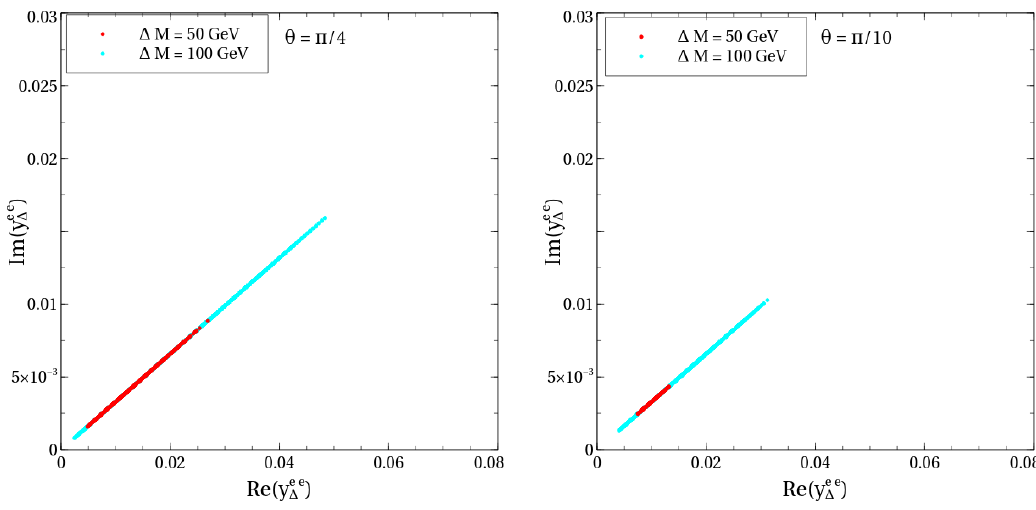
Figure 12 . Points maintaining (cid:1) a (cid:22) within its 2 (cid:27) range and BR (cid:28) ! (cid:22) (cid:22)ee within the quoted limit plotted in the Re( y ee ) Im( y ee ) plane for (cid:18) = (cid:25) (left) and (cid:25) (right). A normal neutrino mass (cid:1) (cid:1) 4 10 (cid:0) hierarchy is assumed. The color coding is explained in the